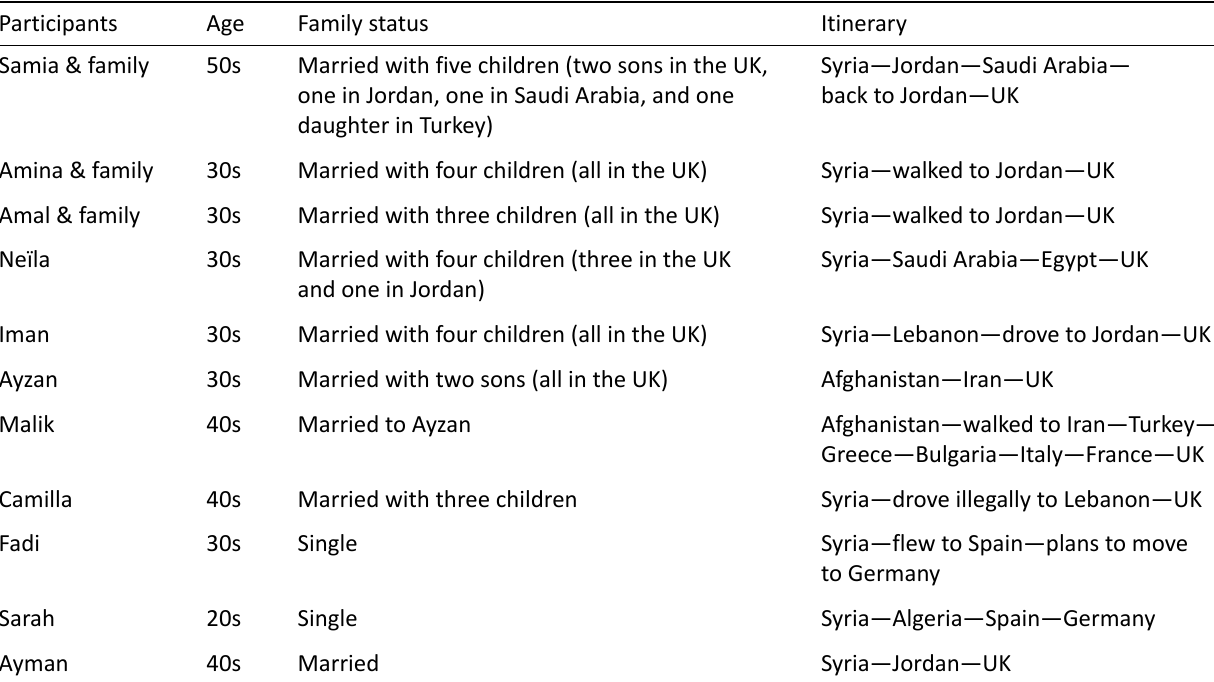
Table 1. An outline of the participants’ social status and migration itinerary.